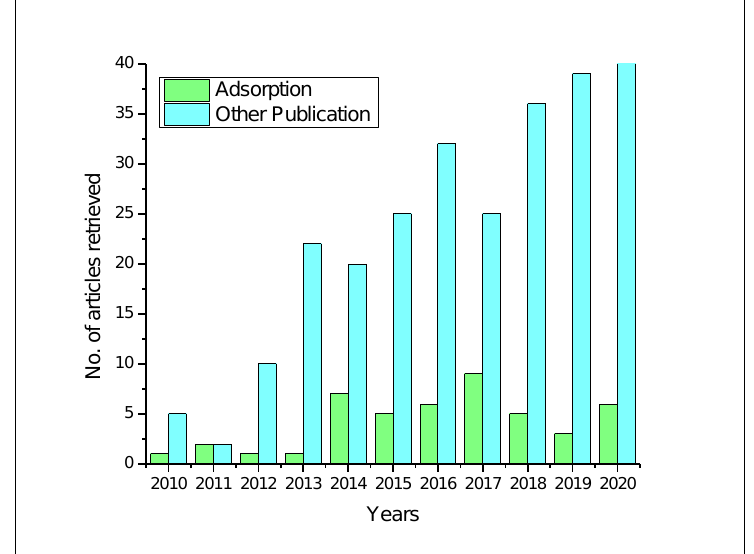
Figure 1. Recent research progress on semicoke adsorption.